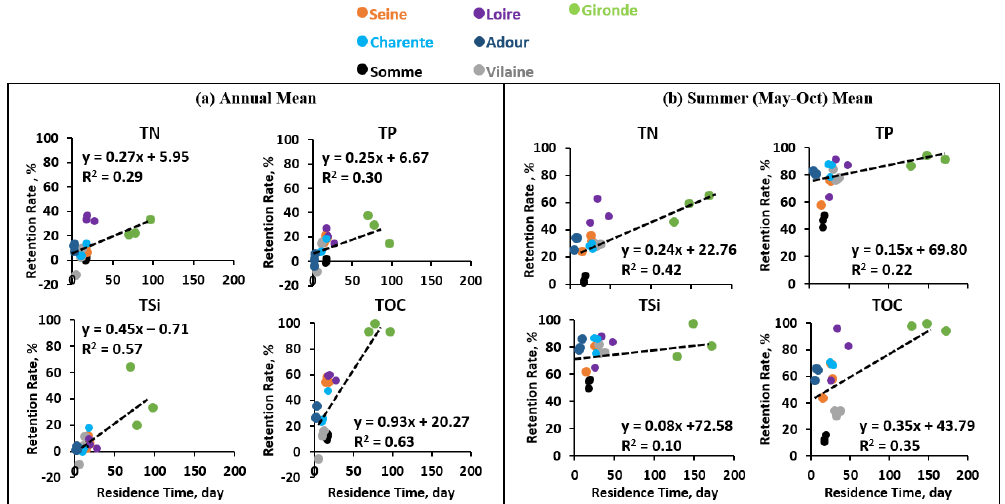
Figure 7. The relations between the annual retention rate for nutrients, including total nitrogen (TN), total phosphorus (TP), total silica (TSi), and total organic carbon (TOC), and the freshwater residence time for the estuaries studied (the Somme, Seine, Vilaine, Loire, Charente, Gironde, and Adour estuaries) for the 3 years of 2014–2016. (a) Annual mean. (b) Summer (May–October) mean.